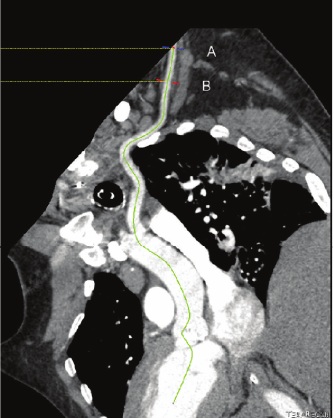
Figure 2: Curved multiplanar TeraRecon reconstruction of axillary artery with measurement at point B in axillary artery.